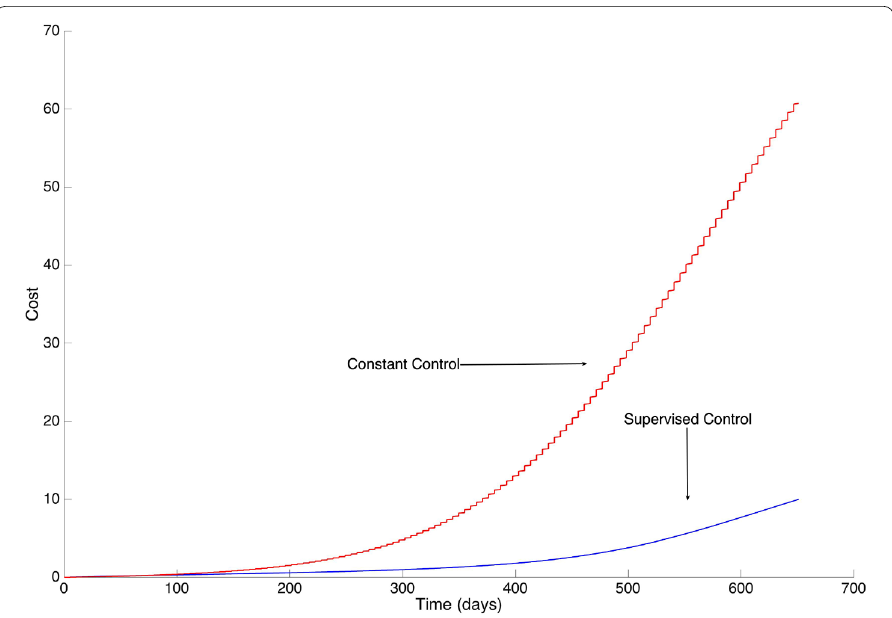
Figure 8 A comparison between the costs of the strategies with supervised control and constant control